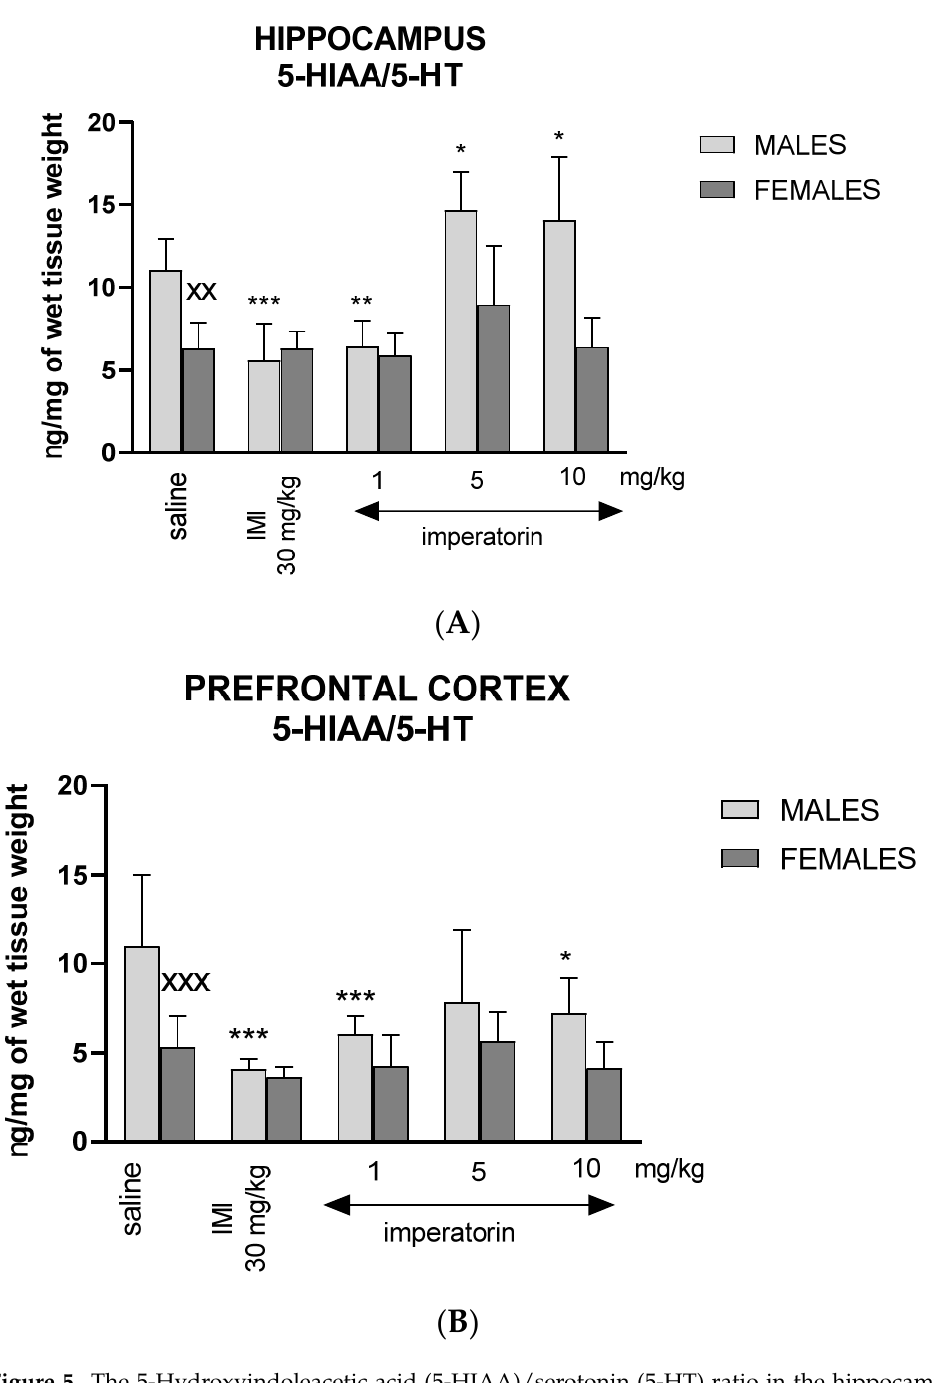
Figure 5. The 5-Hydroxyindoleacetic acid (5-HIAA)/serotonin (5-HT) ratio in the hippocampus ( A ) and prefrontal cortex ( B ) after imipramine (IMI) and imperatorin injections ( i.p. ). Imipramine (IMI, 30 mg/kg, i.p. ) and imperatorin (1, 5, and 10 mg/kg, i.p. ) were administered 30 min before the FST. The hippocampus ( A ) and prefrontal cortex ( B ) were dissected immediately after the test; n = 8–10; mean ± SD; * p < 0.05, ** p < 0.01, *** p < 0.001 vs. saline-treated control group, XX p < 0.01, XXX p < 0.001 vs. male group; Bonferroni’s test.